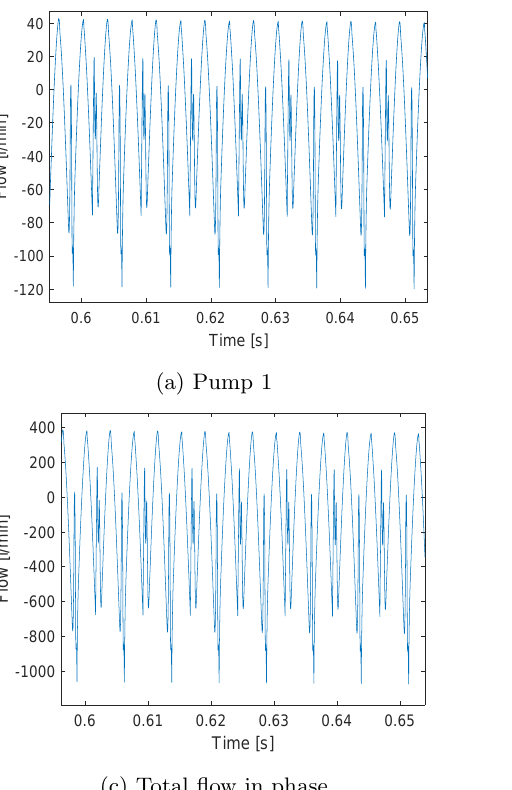
(d) Total flow 180 ◦ out of phase